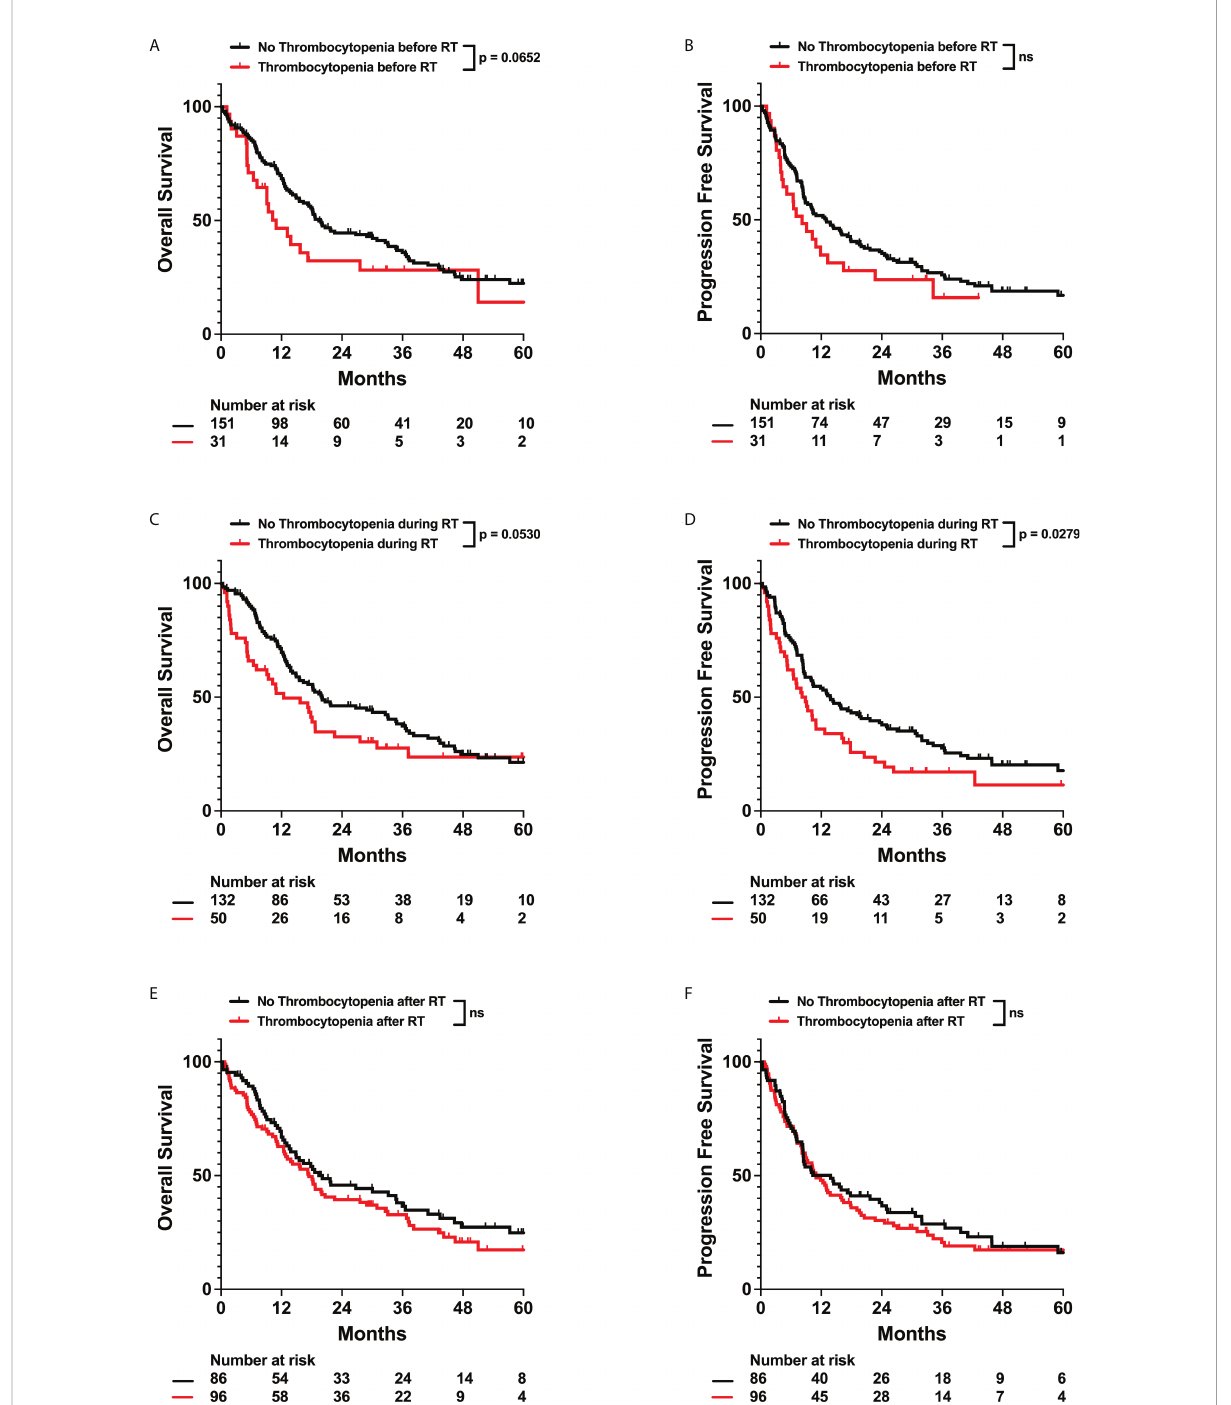
FIGURE 6 Effects of Thrombocytopenia on OS and PFS. Kaplan-Meyer plots of OS and PFS comparing patients with thrombocytopenia (A, B) before, (C, D) during, (E, F) or after radiation treatment. Statistical analysis was performed using Cox Proportional Hazards tests. OS, Overall Survival; PFS, Progression Free Survival; RT, Radiation therapy. “ ns ” for all fi gures stands for not signi fi